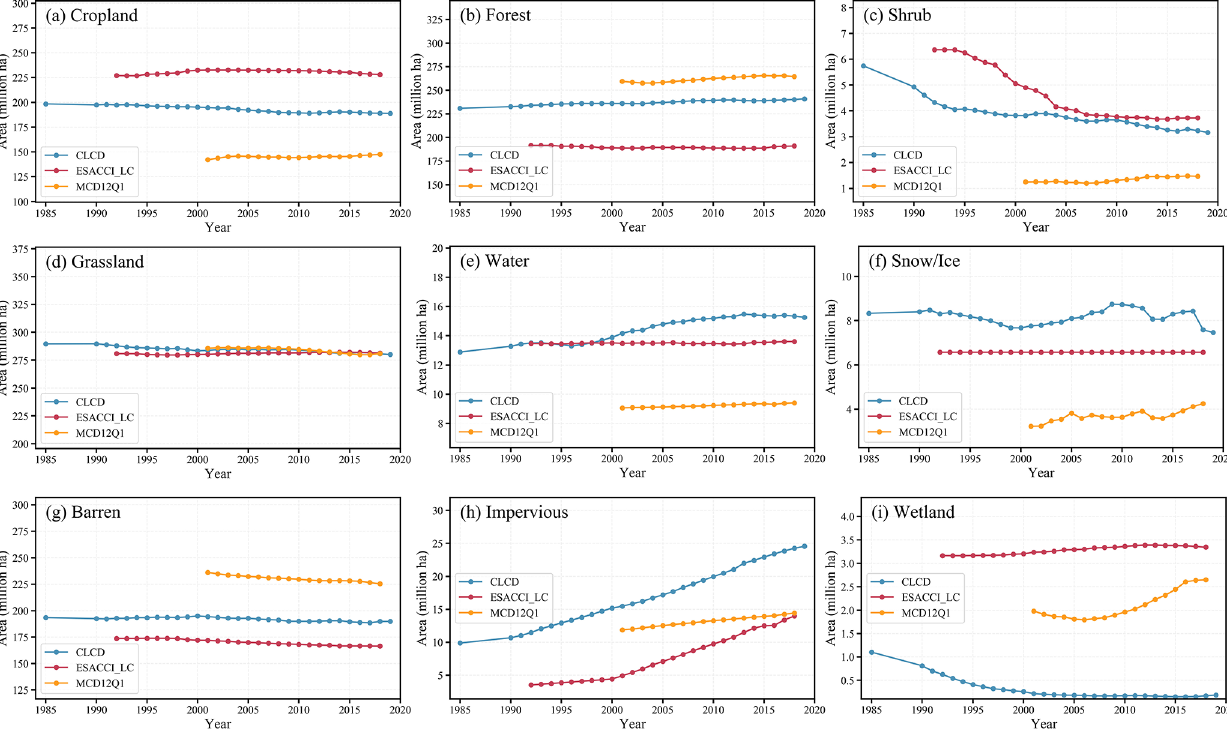
Figure 12. Temporal changes in area of different land covers in China from 1985 to